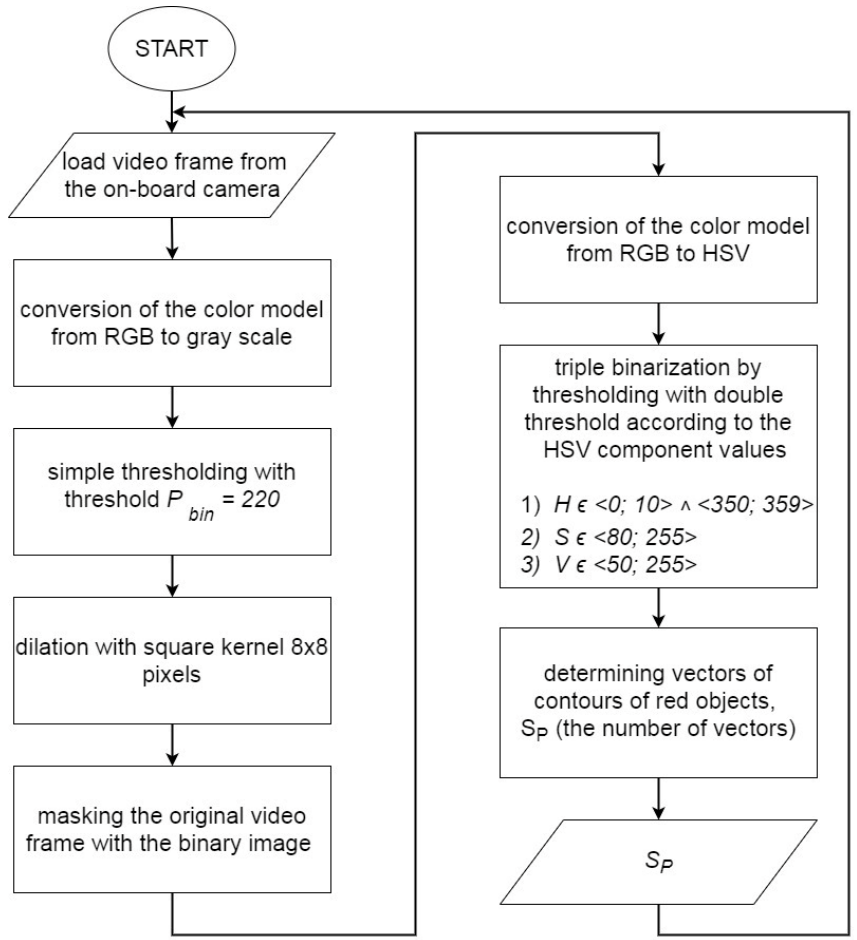
Figure 4. The image-processing algorithm, determining the number of red PAPI lights in the P bin — binarization threshold: H , S , V —pixel color components; S P —number of red PAPI lights. Any lights on a raw picture obtained from the camera are represented by small groups of pixels in a color brighter than the background (Figure 5).